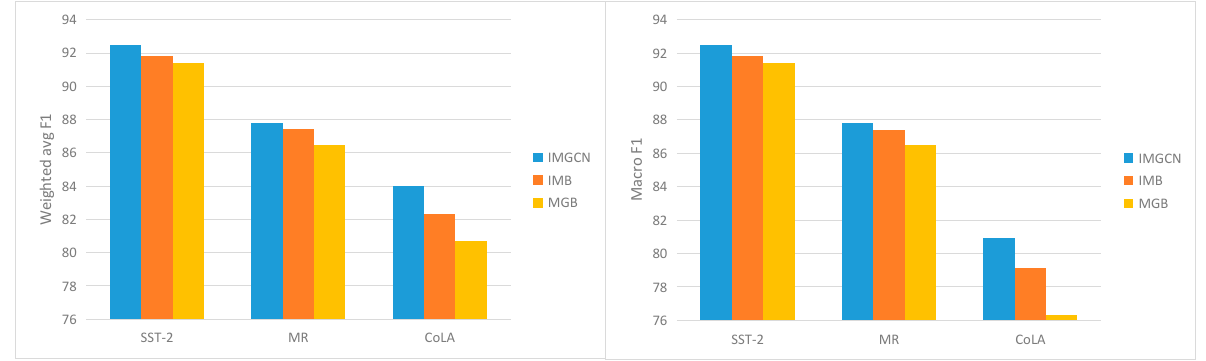
Figure 5. Histogram of experimental results of ablation study.